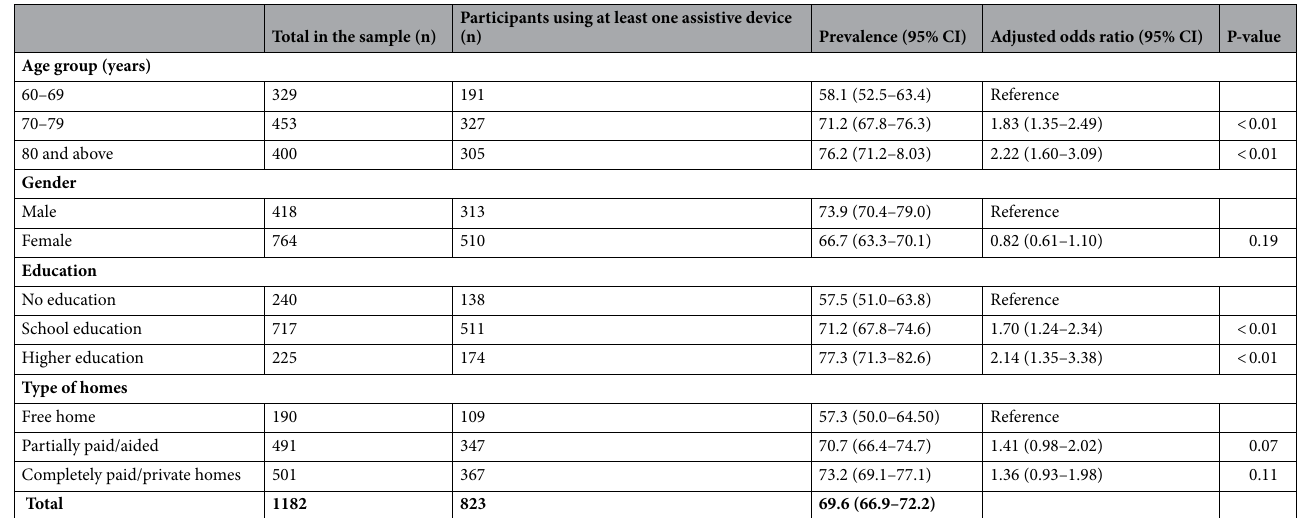
Table 5. Association of at least one assistive device used with sociodemographic characteristics (multiple logistic regression